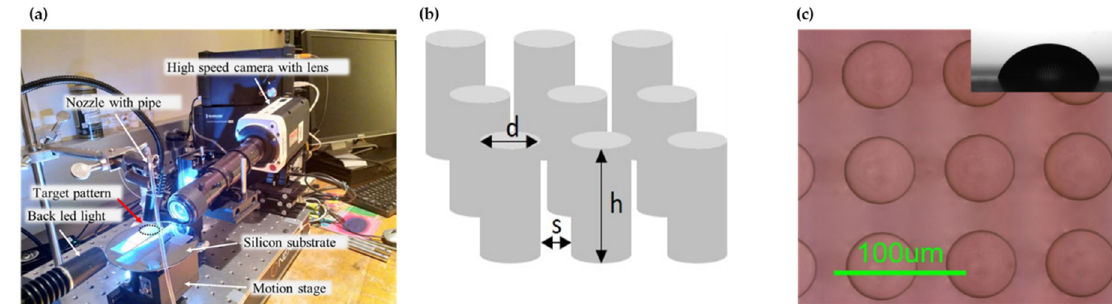
Figure 1. ( a ) Experimental setup of high-speed camera and staging area, ( b ) digital rendering of micropillars with diameter, spacing, and height, ( c ) image of micropillared surface from above taken with a microscope, and inset of side profile of sessile droplet on wafer surface.